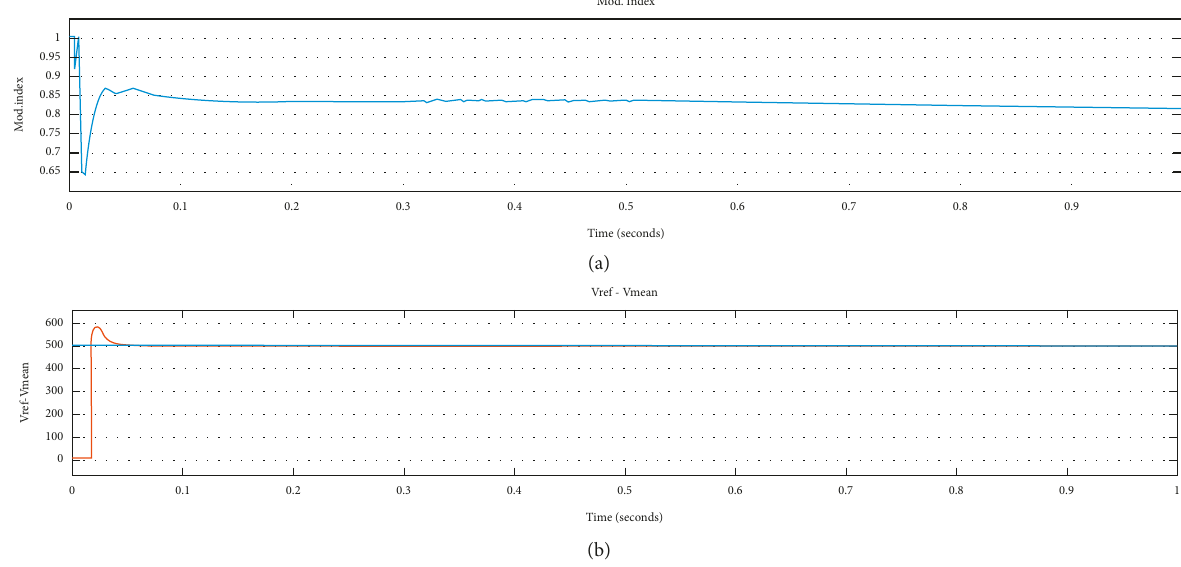
Figure 11: VSC outputs: (a) modulation index and (b) V